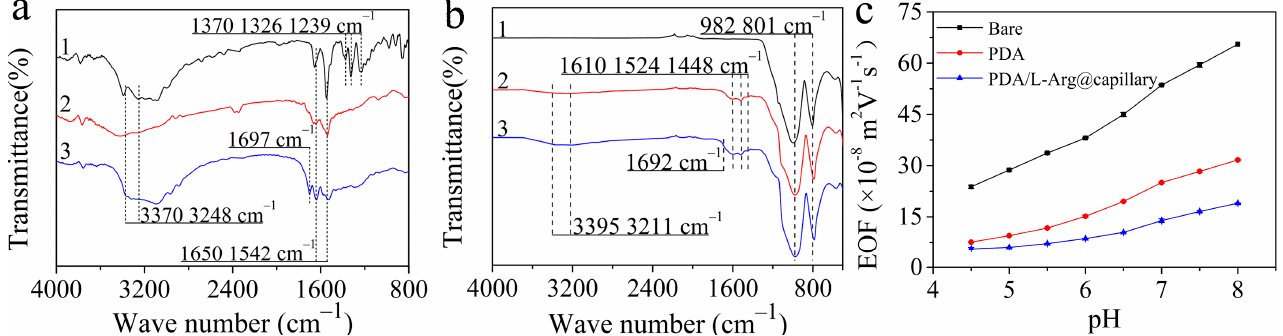
Figure 3. ( a ) FTIR spectra of dopamine (1), PDA (2), and PDA/L-Arg composite (3). ( b ) ATR-FTIR spectra of unmodified (1), PDA-coated (2), and PDA/L-Arg-coated quartz sheets (3). ( c ) The electroosmotic flow mobilities of bare column, PDA-coated column, and PDA/L-Arg@capillary at different buffer pH values ranging from 4.5 to 8.0. EOF marker, DMSO; Buffer, 100.0 mM boric acid, 10.0 mM ammonium acetate, 6.0 mM ZnSO 4 , 6.0 mM L-Arg; Capillary: 50 µm i.d. × 35 cm length (26.5 cm effective); sample injection pressure and time at 35 mbar and 5 s; 25 °C; voltage, − 20 kV; UV detection at 214 nm.